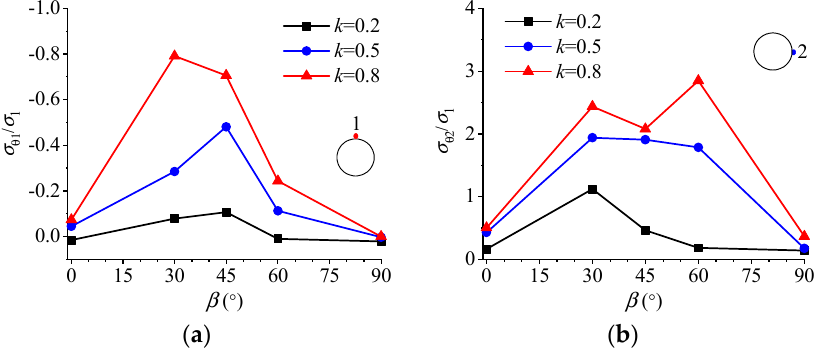
Figure 28. σ θ 1 / σ 1 and σ θ 2 / σ 1 vs. joint inclination angle β at σ 1 = σ p . ( a ) σ θ 1 / σ 1; ( b ) σ θ 2 / σ 1 .